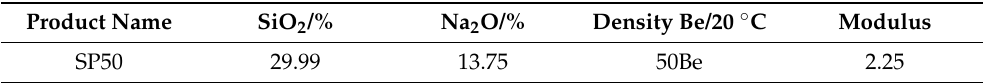
Table 2. Chemical composition and physical properties of water